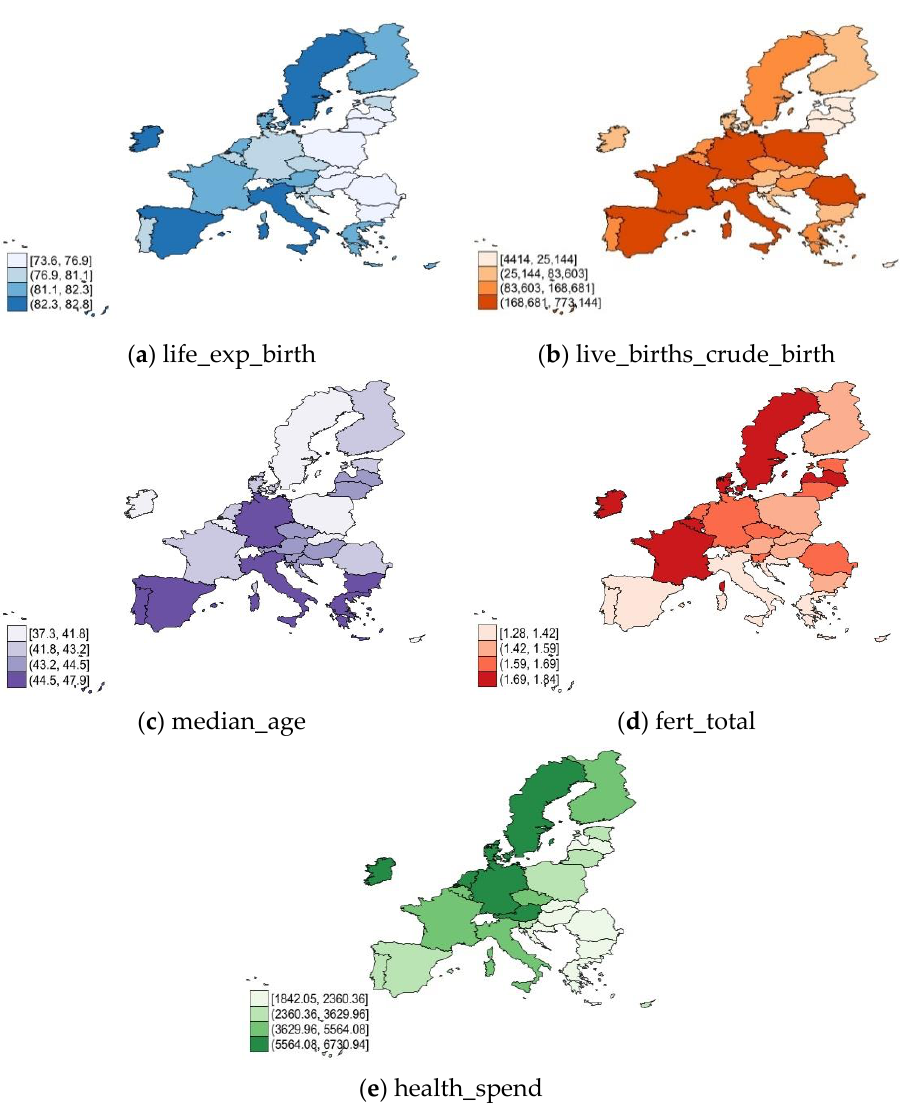
Figure 1. Health in EU-27, 2020: ( a ) life expectancy; ( b ) live births rate; ( c ) median age; ( d ) total fertility; ( e ) health spendings. Source: own process in Stata 17.